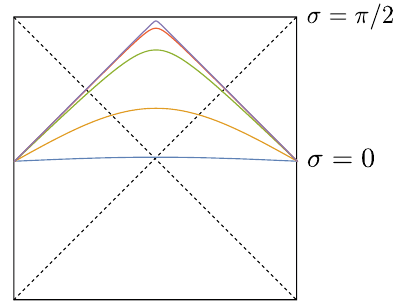
Figure 9 . The geodesics in dS 3 which go from one horizon to the partner horizon. They are shown extended into the interiors of the static patches. There are no real spacelike geodesics connecting horizons beyond σ = π/ 4 , where they approach a null geodesic. The full geodesics from the static patch origin at σ = 0 to its antipodal point have equal length and are part of the infinite family of degenerate geodesics connecting antipodal points on de Sitter